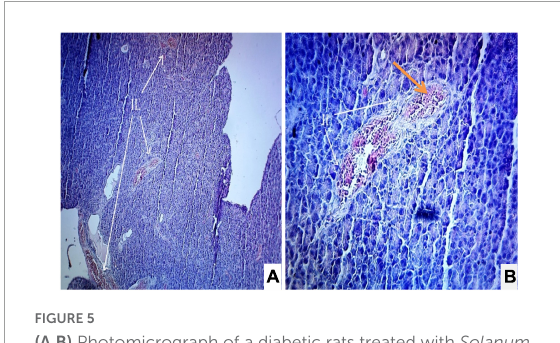
FIGURE5 (A,B) Photomicrograph of a diabetic rats treated with Solanum torvum fruits extract (160 mg/kg/b.wt.) section from pancreas showed minimal restoration of normal cellular population and regeneration of β -cells of islets of Langerhans. The acinar cells are seen to be normal. (A) H & E 10X; (B) H & E 40X. IL, islets of Langerhans cells.